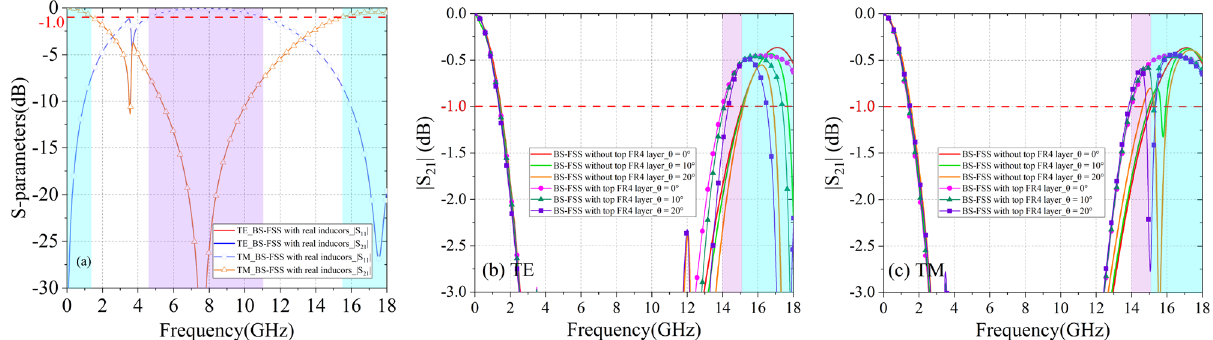
Figure 7. ( a ) At normal incidence, frequency response of proposed BS-FSSs. ( b ) At TE-polarization, transmission coefficients of BS-FSS with/without top FR4 layer. ( c ) At TM-polarization, transmission coefficients of BS-FSS with/without top FR4